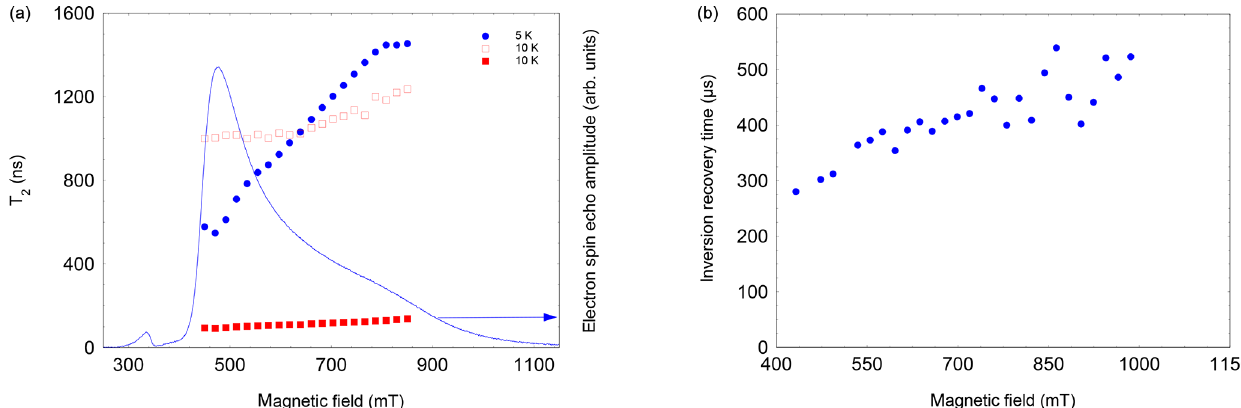
Figure 5. (a) Field and temperature dependence of the two-pulse echo decay of NO@C60-OH3. The 5K data set could be satisfactorily fitted assuming a single exponential; the 10K data required a bi-exponential fit. Both components were of similar magnitude, with the shorter T 2 larger in amplitude. (b) Field dependence of T 1 of NO@C60-OH3, measured using an inversion recovery pulse sequence at 3.6K.